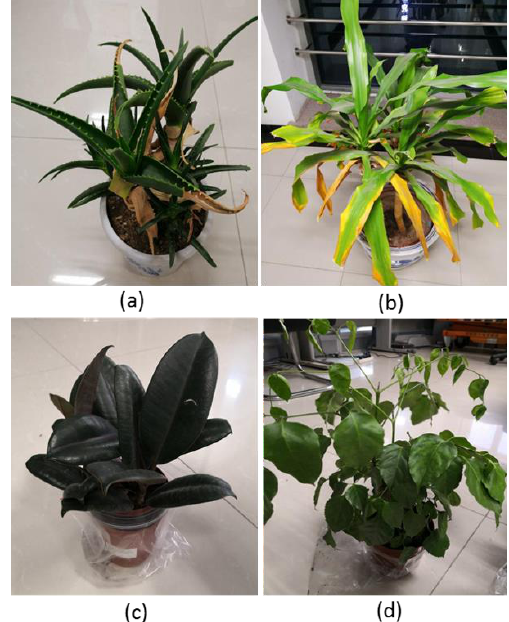
Figure 6. Four plants under test: ( a ) aloe with yellow and green leaves, ( b ) dracaena with yellow and green leaves, ( c ) balata and ( d ) radermachera.